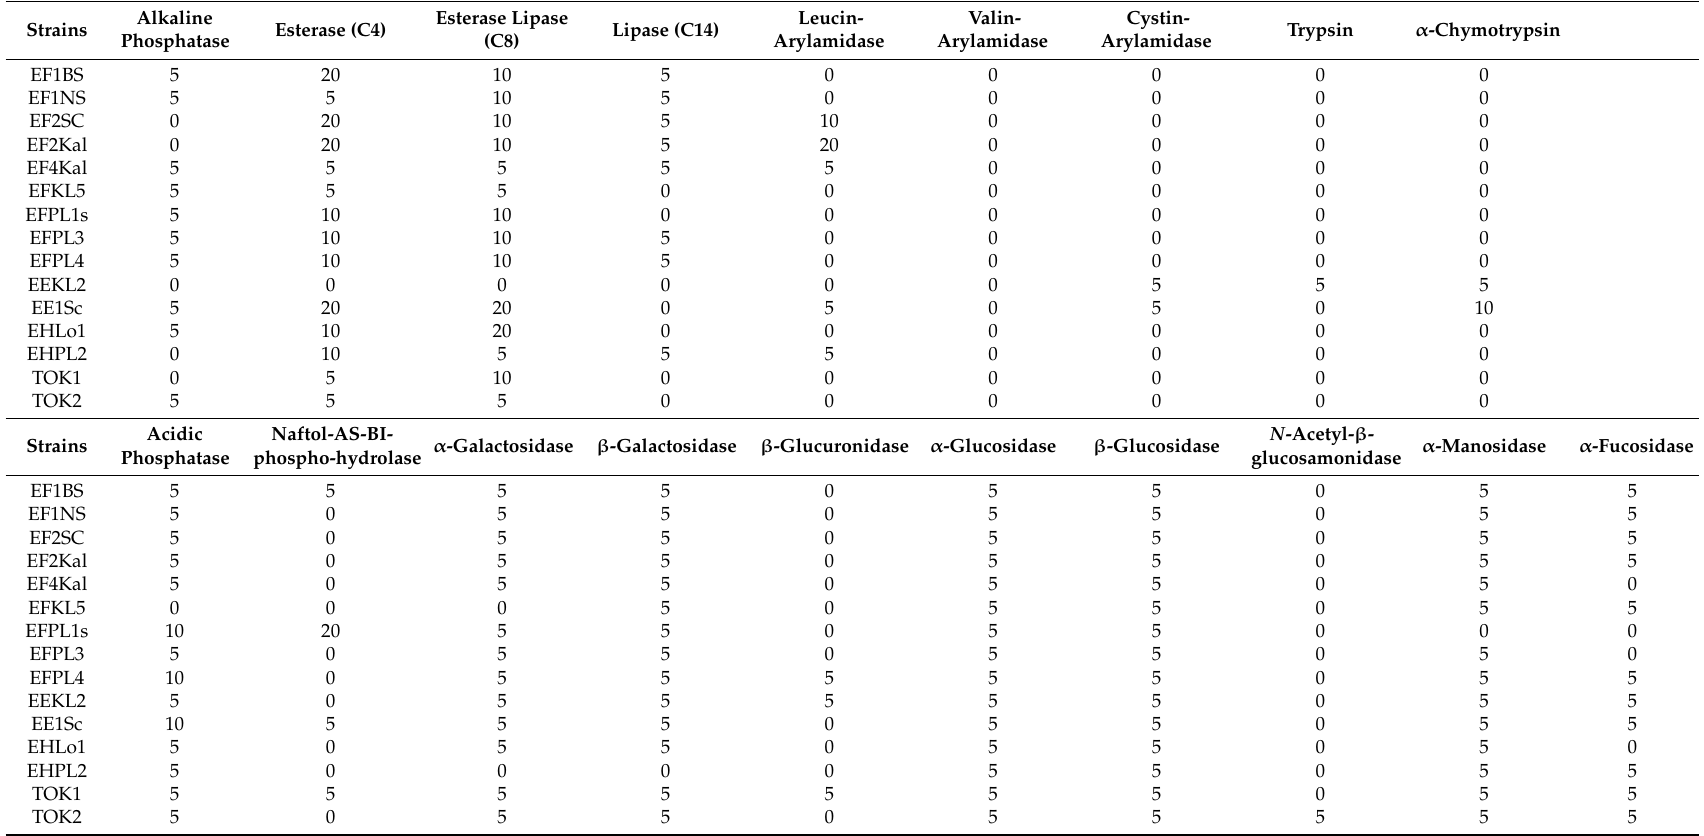
Table 2. Enzyme production in nanomoles